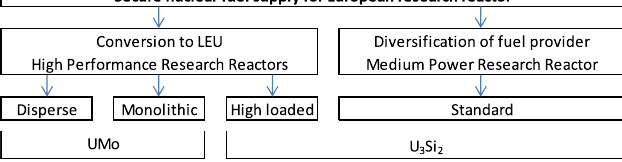
Fig. 2. Key issues and related nuclear fuel development to secure fuel supply for European research reactors.